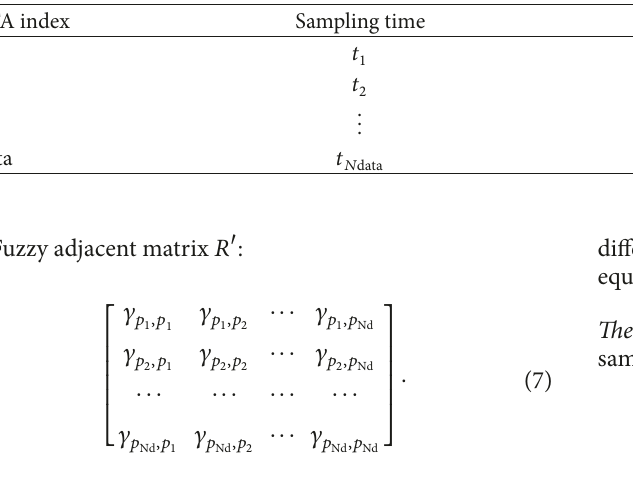
Algorithm 1: Node clustering. Table 3: The original sampling data